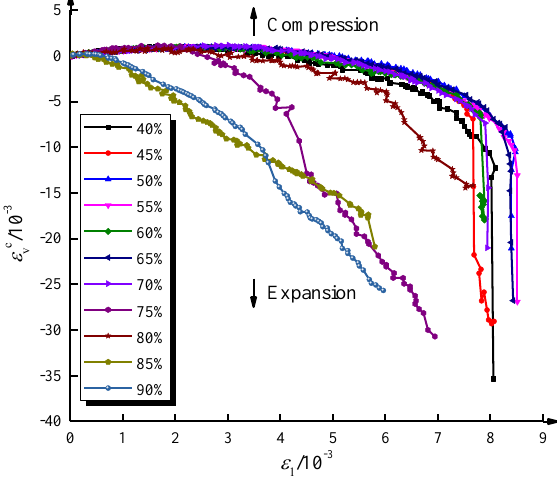
Figure 7. Volume strain characteristic curves of damaged sandstone cracks.